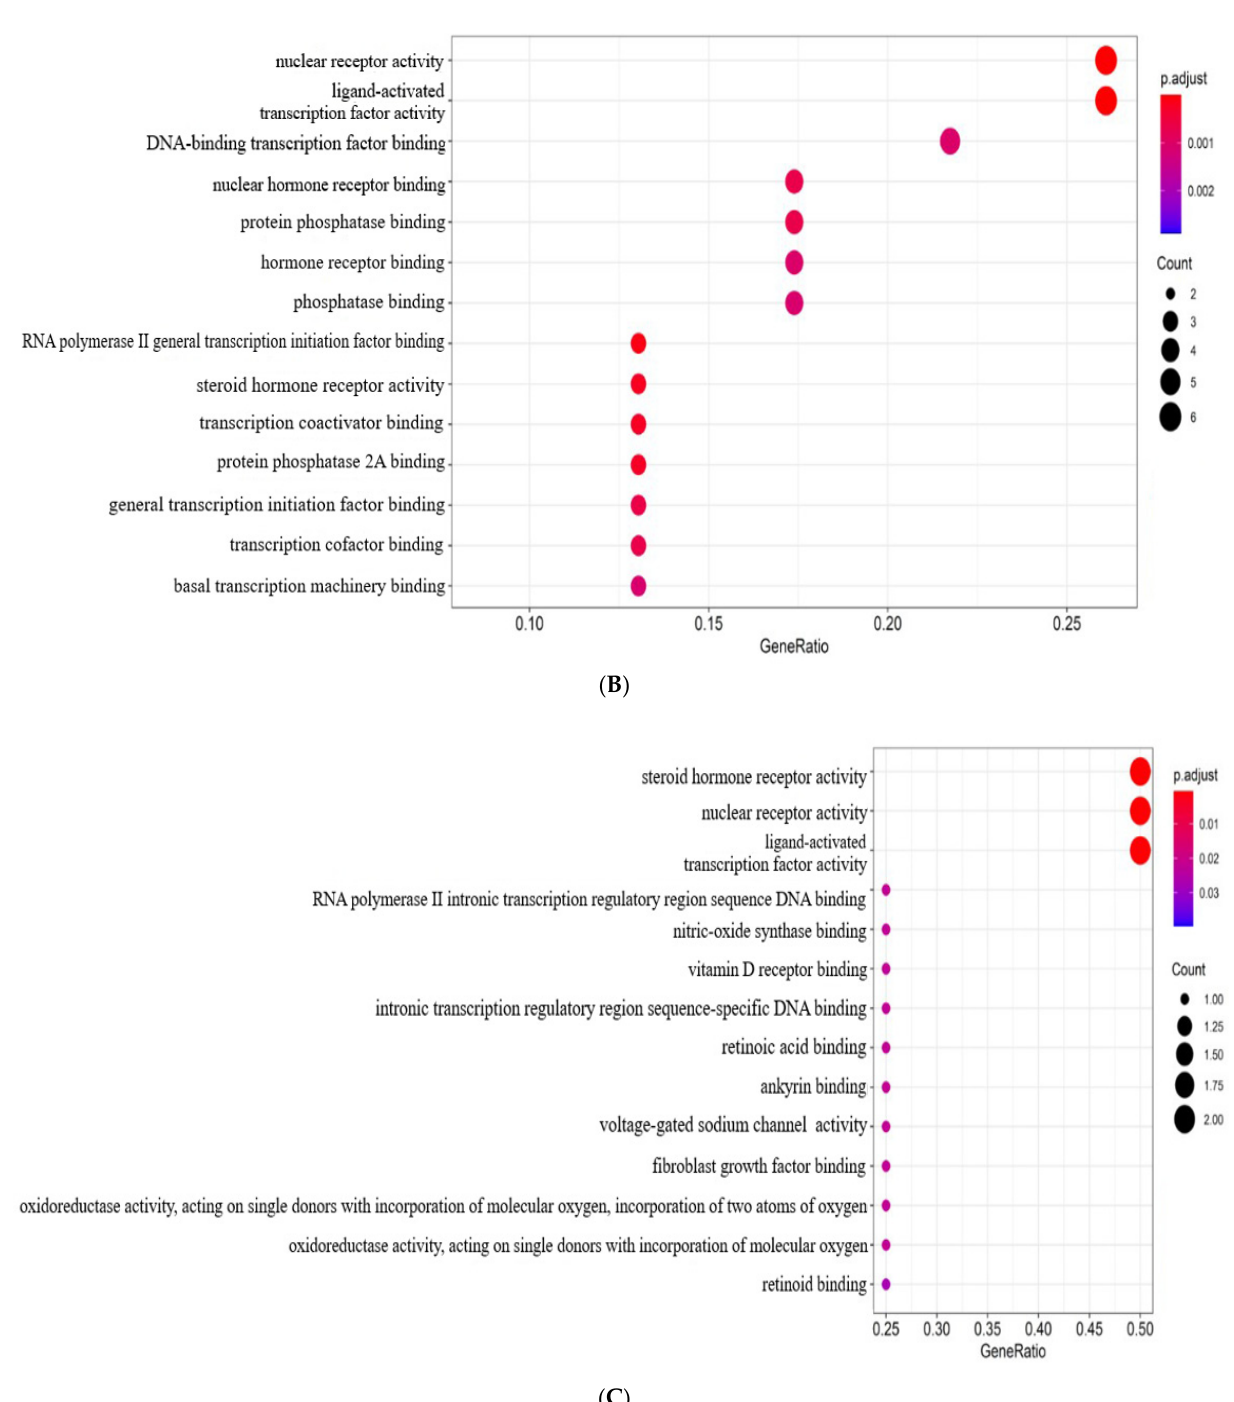
Figure 1. Active component-target network and gene ontology (GO) function enrichment analysis of active components of Paeonia Lactiflora (PL) , Poria Cocos (PC) , and androgenetic alopecia (AGA). ( A ) Active component-target network of primary active ingredients of Paeonia Lactiflora (PL) and Poria Cocos (PC). ( B ) GO function enrichment analysis results between PL and AGA. ( C ) GO function enrichment analysis results between PC and AGA. Main active ingredients (triangle-purple), targets (rhombus-blue), PC and PL (rectangle-yellow), AGA (dots-black). The X-axis represents the number of genes enriched in each function, and the Y-axis is the name of the function. Different colors represent different degrees of enrichment. The redder color and the bigger bubble indicated a higher degree of enrichment of the target pathways and a smaller p